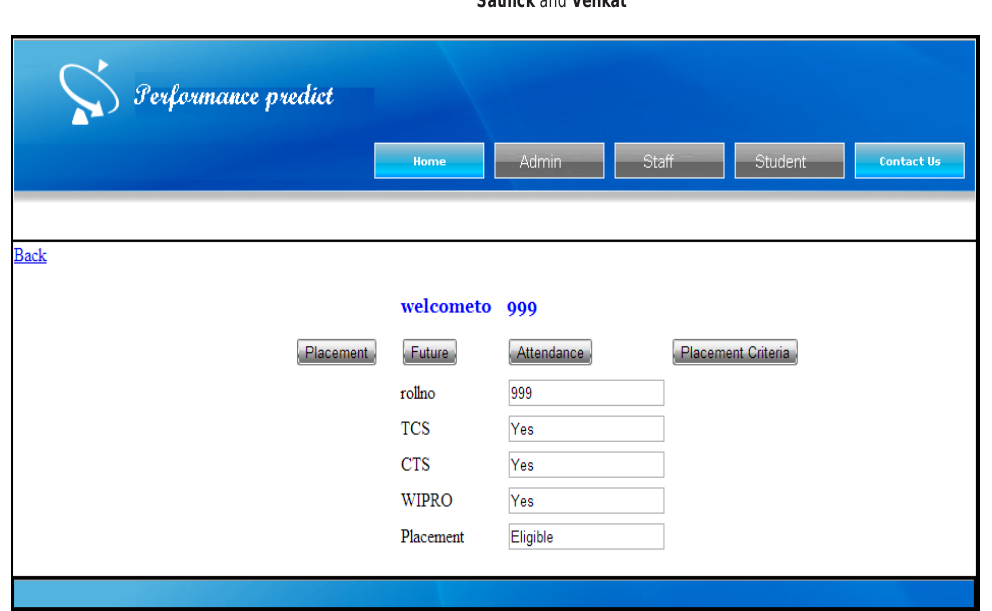
Figure 10. Student eligibility criteria.